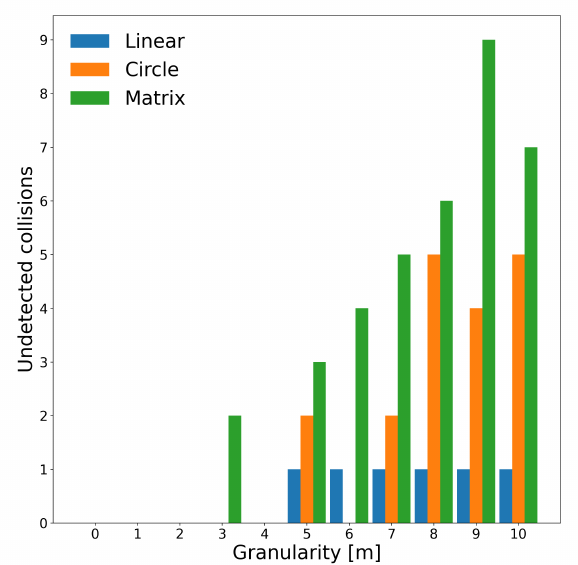
Figure 13. Number of potential collisions that would remain undetected when increasing the granu- larity value.